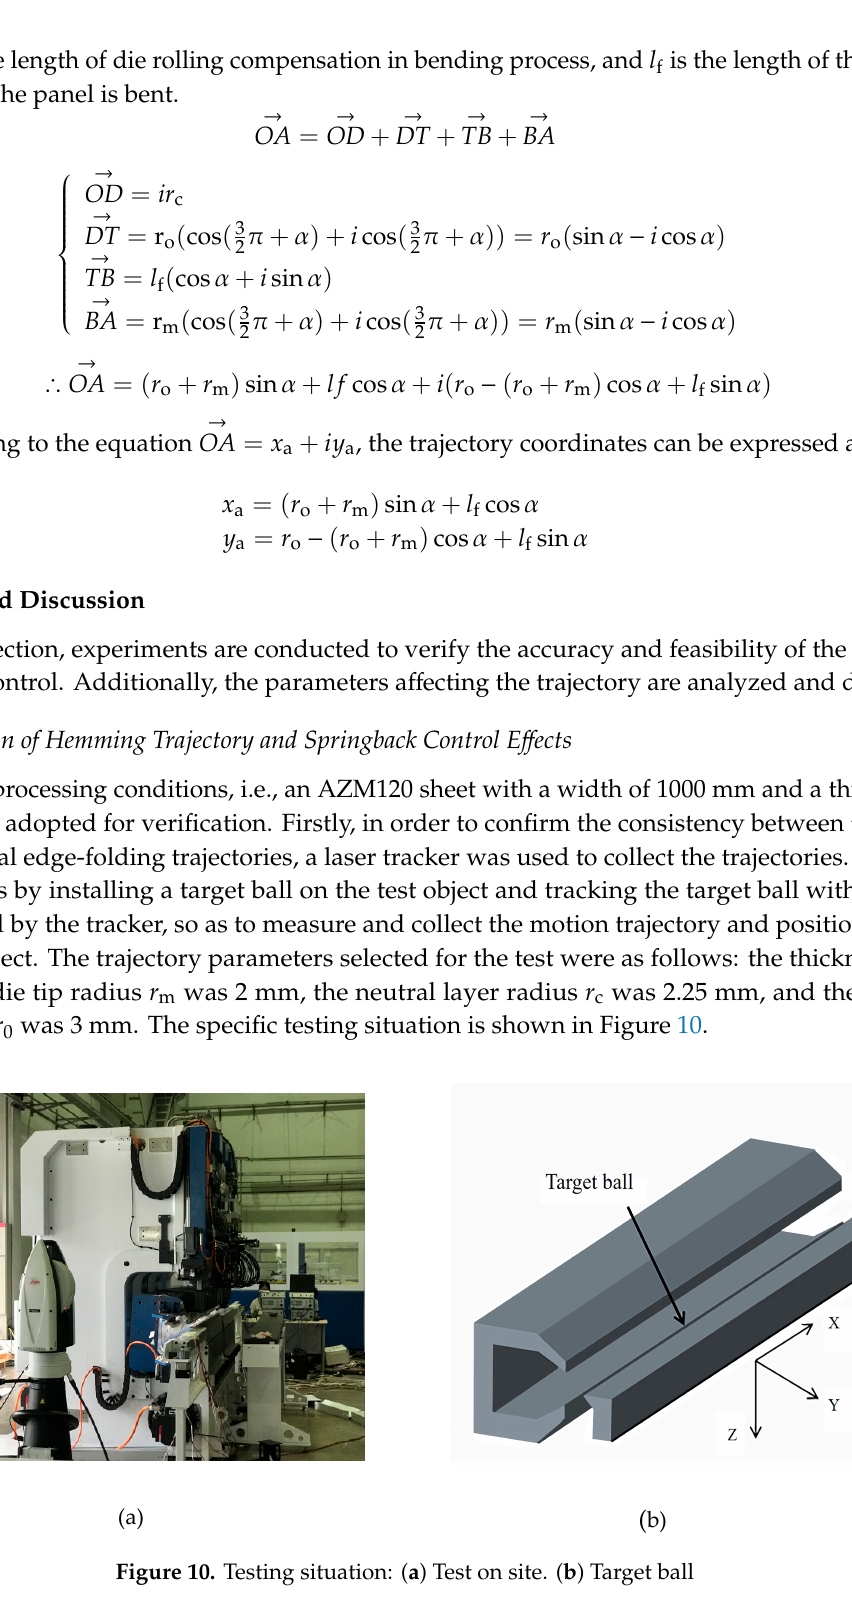
Figure 11. Trajectory comparison. In Figure 11, ‘no-load’ and ‘full-load’ show the experimental results of the actual bending trajectories of the four-side automatic panel bender with no load and full load, respectively. The experimental results of ‘no-load’ were used to prove the accuracy of the theoretical trajectory, while those of ‘full-load’ were used to estimate the impact of the actual structure deformation under load on the trajectory. It was found that the folding trajectories with no load were nearly the same as the theoretical ones (as shown in Equation (19), the mold stiffness was not considered). While there is still an 8% bias between those with full load and theoretical ones; this mainly results from the die deformation caused by the working load. Secondly, in order to confirm the forming angle and the corresponding springback angle, the displacement sensor was used to measure the angle of in-place formation, which was compared with the theoretical springback angle, as shown in Figure 12.